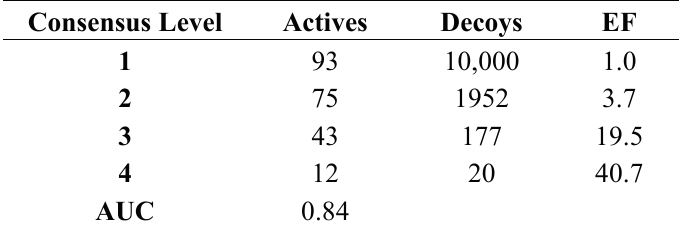
Table 1. Consensus docking results for the enriched database analysis. EF, enrichment factor.